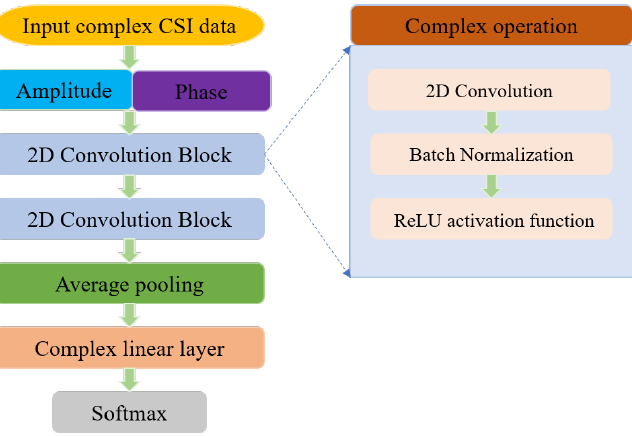
Figure 5. The architecture of the AP-DCN.